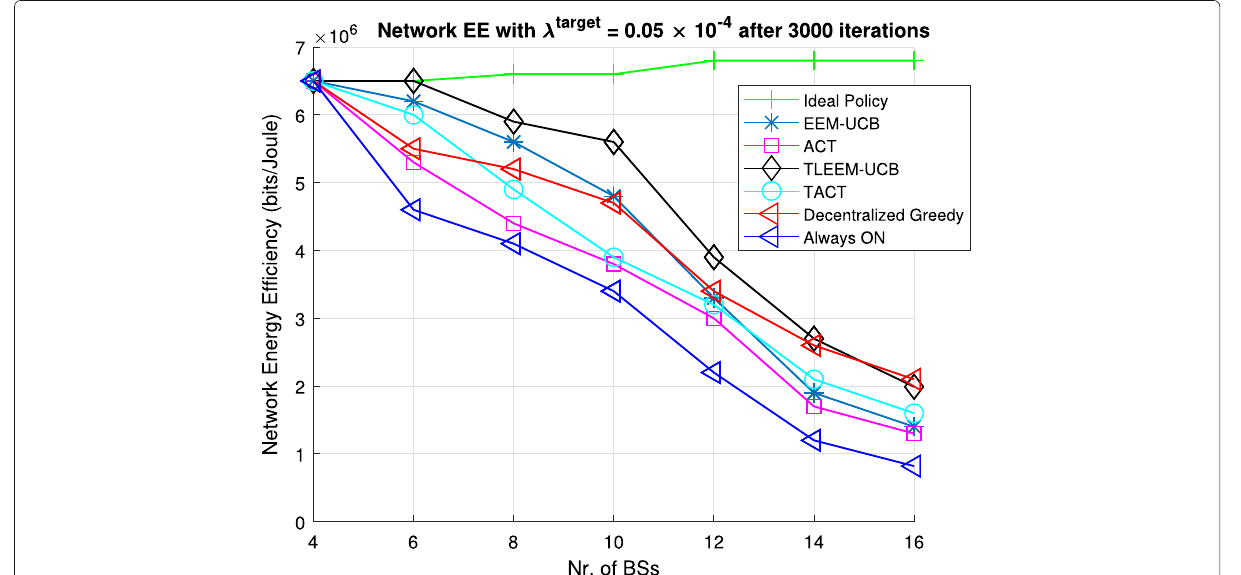
Fig. 6 Network EE obtained with several learning algorithms with respect to the number of BS. The figure compares the network EE achieved by severallearning policies w.r.t.the number of BS, i.e.,from 4 to 16,after3000iterationsofeach algorithmand atargettrafficrate (cid:2) target = 0.05 × 10 −